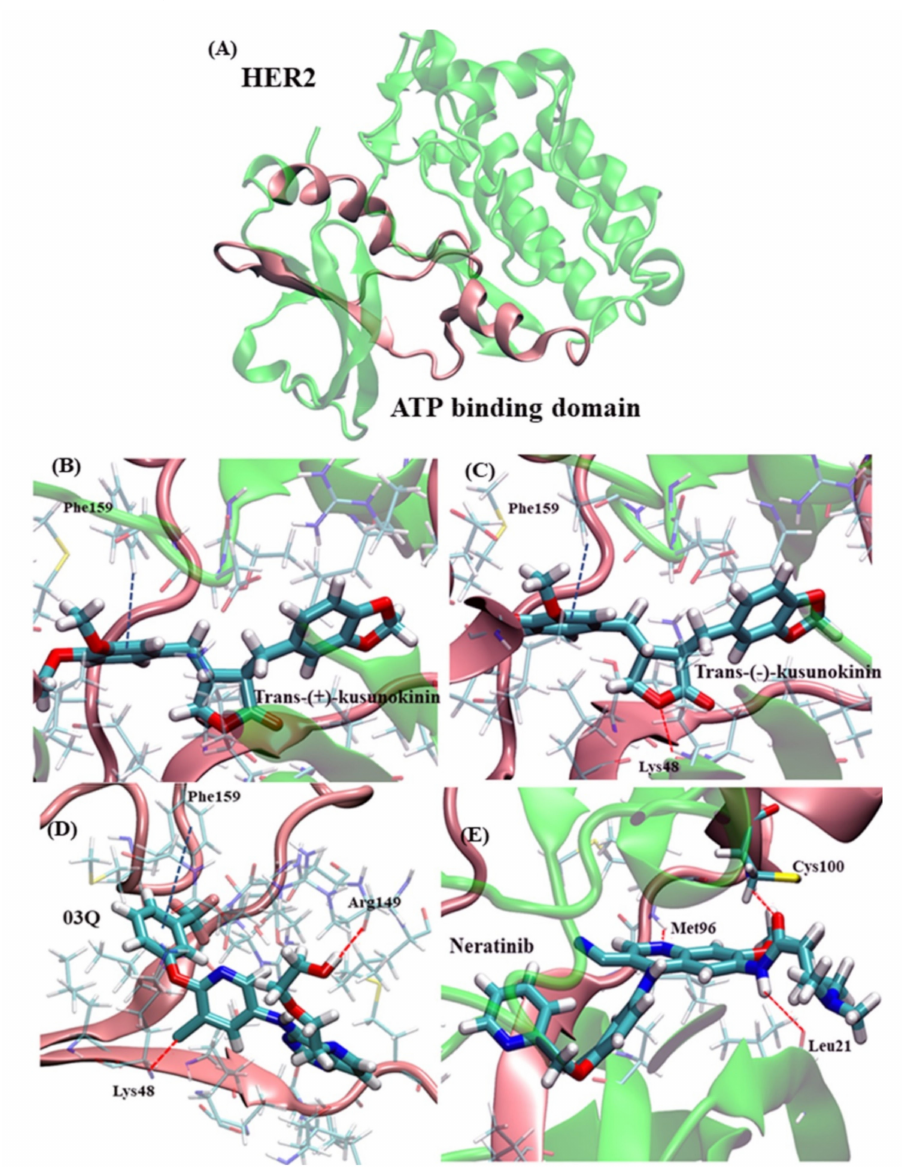
Figure 3. Ligand interaction with HER2 structure. ( A ) HER2 structure and its ATP binding domain (pink), ( B ) trans-(+)-kusunokinin, ( C ) trans-( − )-kusunokinin, ( D ) 03q and ( E ) neratinib. The red line represents hydrogen bonding or hydrogen bond like interaction (red line). Phe159 was responsible for π - π interaction (blue line). The transparent amino acid represents amino acids interacting with the compound through hydrophobic